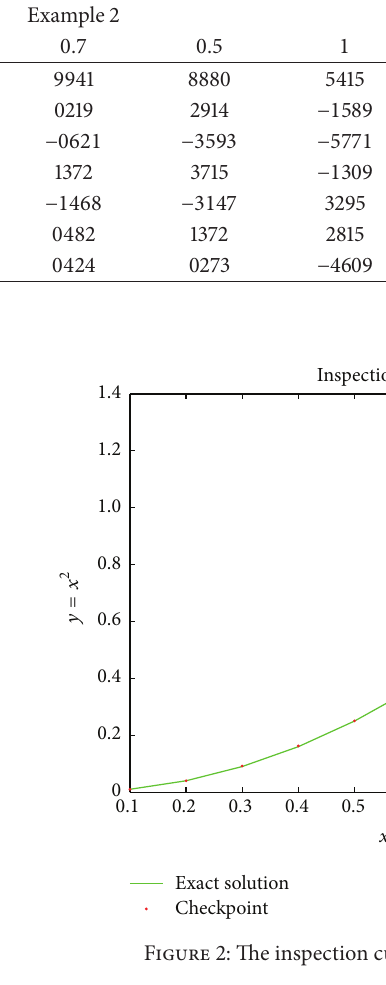
are done by using Lenovo T400, Intel Core 2 Duo CPU P8700, 2.53 GHz, and Matlab version R2010b. The neural